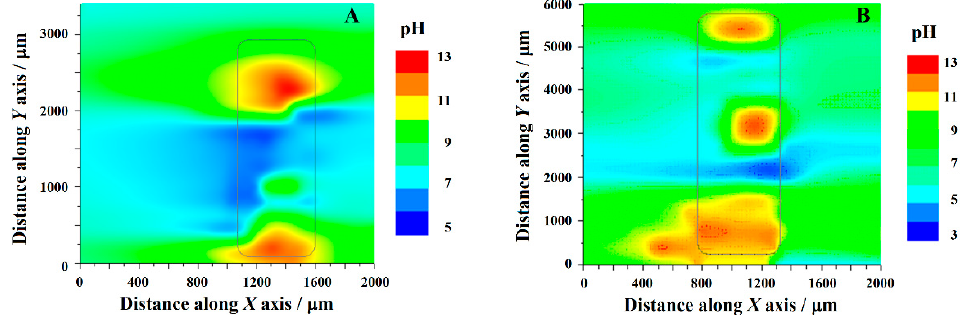
Figure 11. pH quasi-map of cut edges samples immersed in 1 mM NaCl solution. ( A ) Complete coil-coating system with organic coating layers of different thickness at each side (corresponding to sketch #1 in Figure 1C); and ( B ) coil-coating system after removing the organic coating layers at each side (corresponding to sketch #2 in Figure 1C). The approximate location of the specimen is indicated. The line scans were taken every 400 µ m along the Y axis, and always from the right to the left.